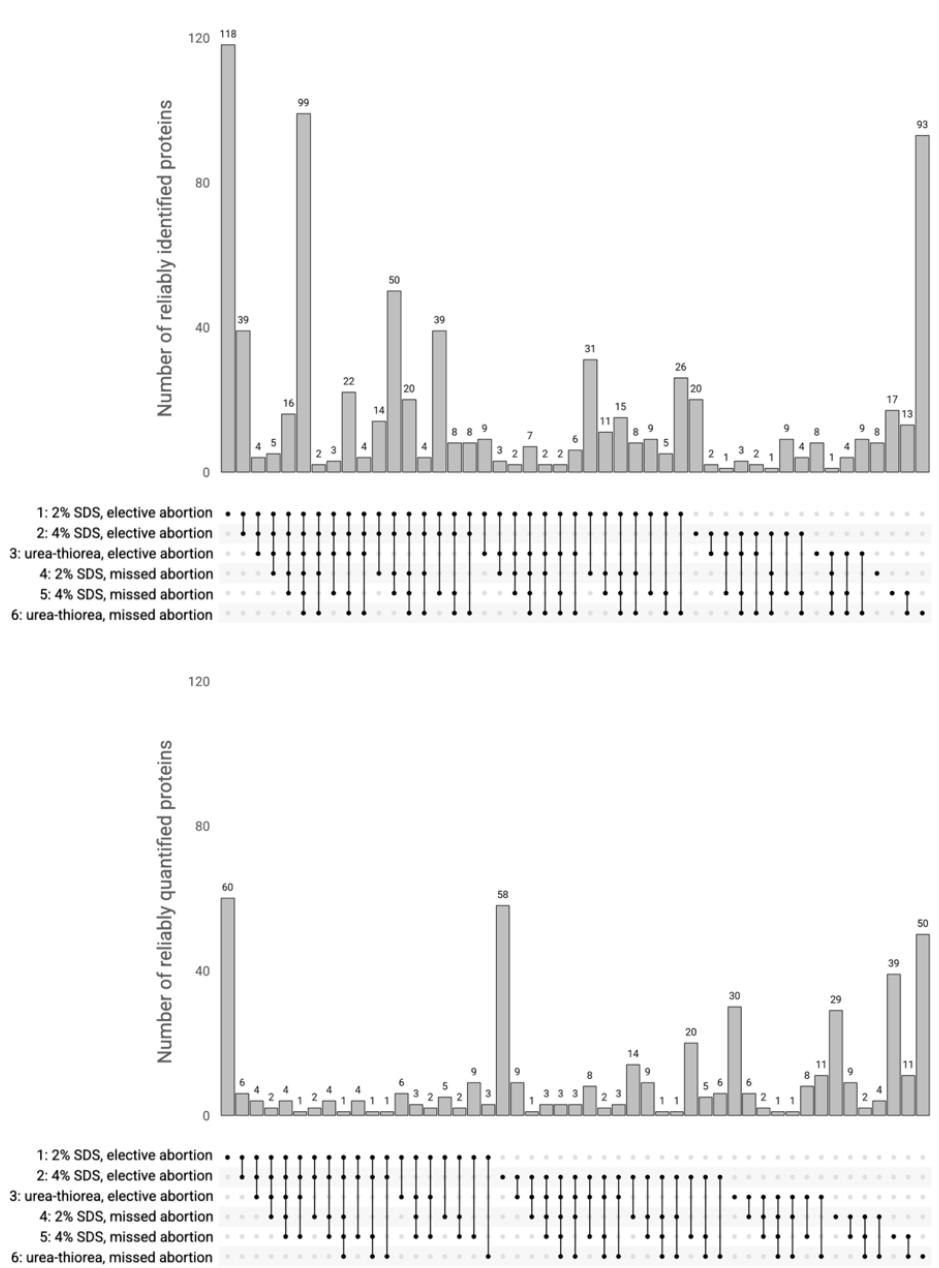
Figure 3. UpSet plot showing the number of shared proteins (i.e., intersections) between six human chorionic datasets. Upper panel—intersections of the reliably identified (I reliably ) proteins; lower panel—intersections of the reliably quantified (Q reliably ) proteins. Datasets are given as their numbers in rows of the table.